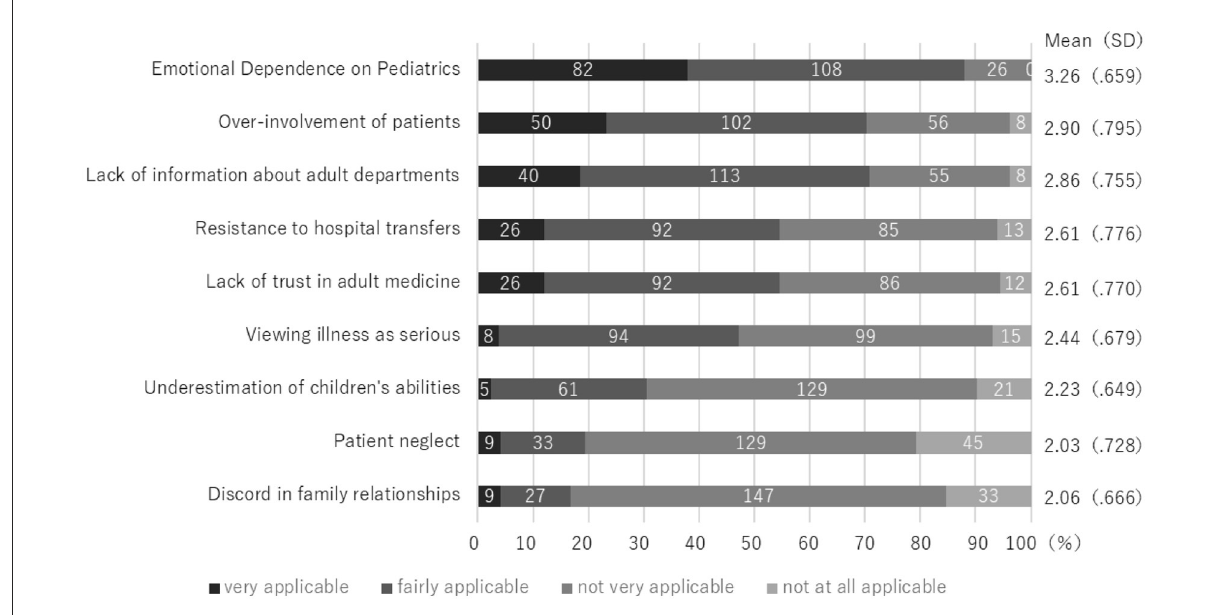
FIGURE1-2 Barriers to Transition from Pediatric to Adult Care: Parents Factors ( n = 216).